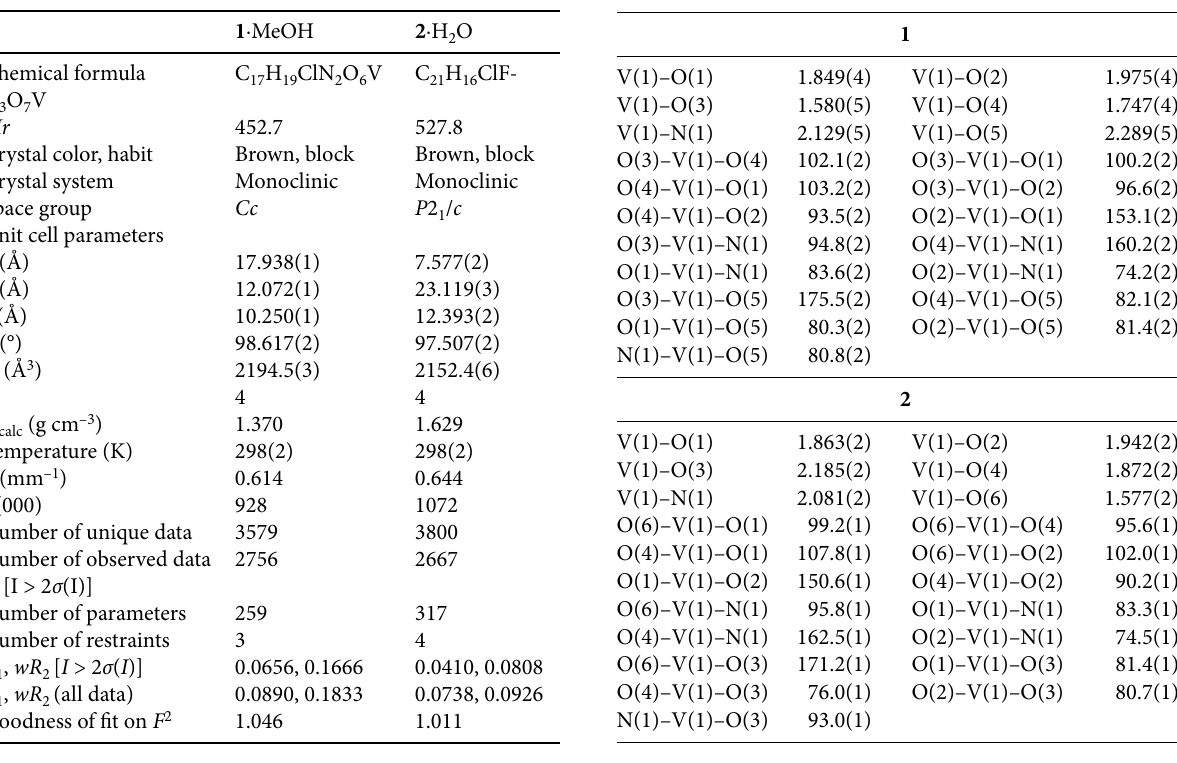
Table 1 . Crystallographic data and refinement parameters for the complexes